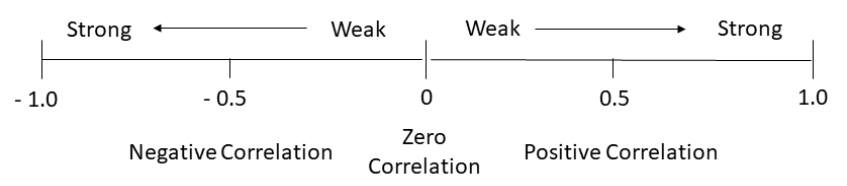
Figure 2. Pearson correlation scale.